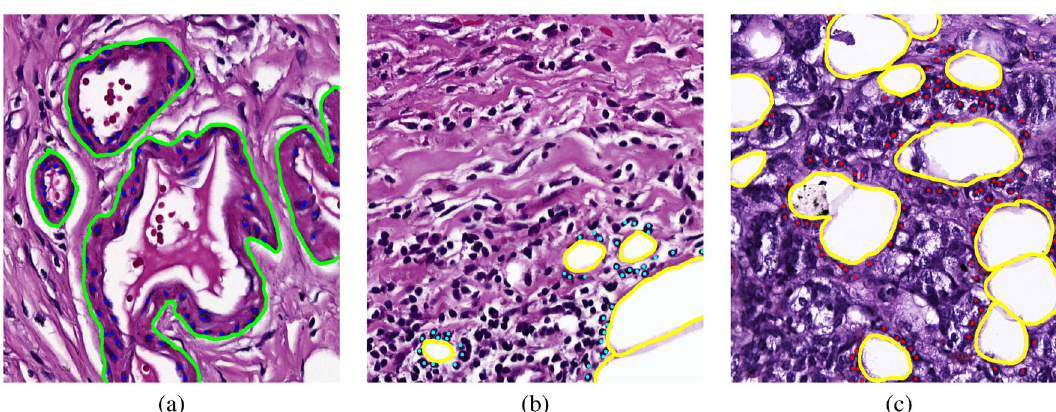
Figure 2. ( a ) Blood vessels (green) have a lumen enclosed by a thin layer of endothelial cells, ( b ) Adipocytes (yellow) are signet-ring structures consisting of white spaces surrounded by a cytoplasmic membrane.